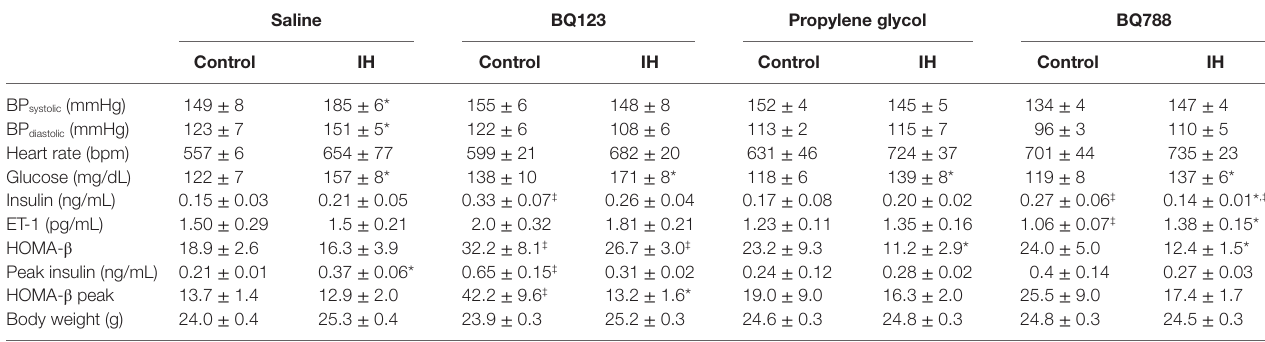
TaBle 1 | Biochemical and physiological variables in all treatment